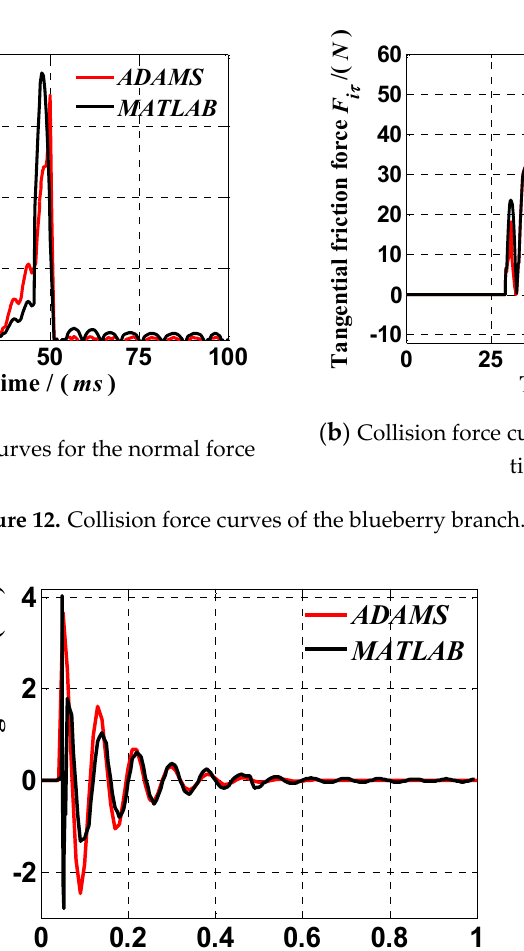
Figure 11. Deformation surface for the blueberry branch.